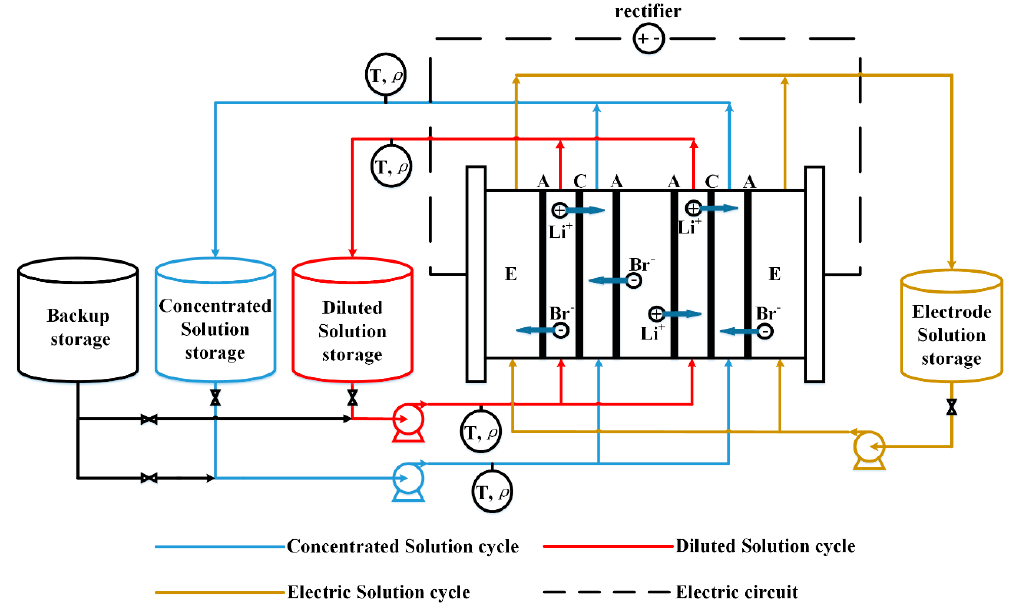
Figure 2. Schematic diagram of electrodialyzer.